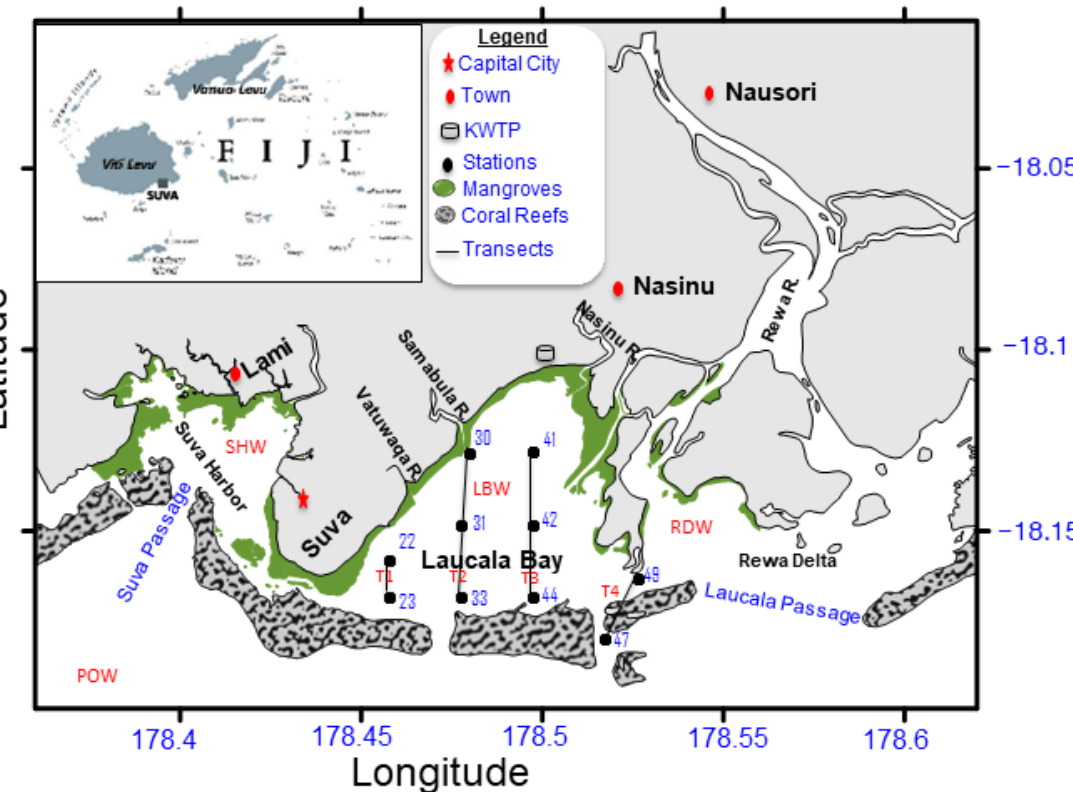
Figure 1. Site maps of the Suva Lagoon showing the study area Laucala Bay in the island of Viti Levu, Fiji Islands. Study Scheme 22. transects (T1–T4 in black solid line and red labels).KWTP refers to the Kinoya Wastewater Treatment